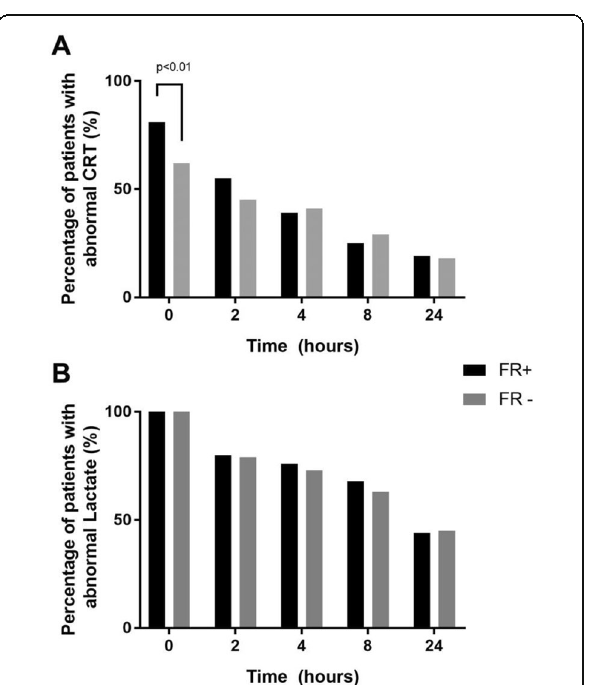
Fig. 2 (abstract 000858). See text for